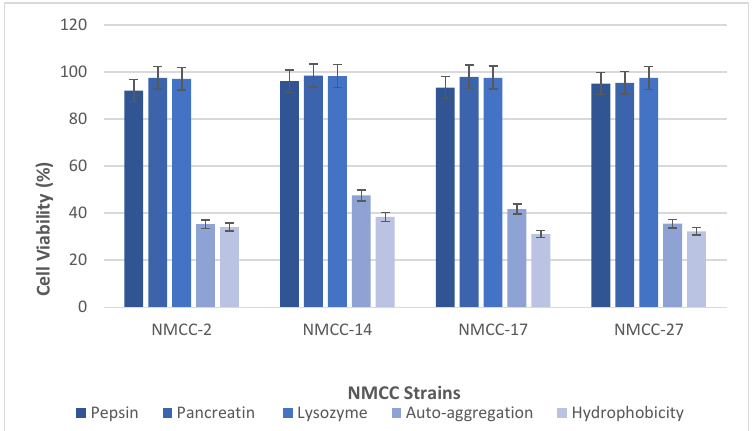
Figure 2. Evaluation of different physiological properties of LAB strains. In vitro values ( n = 3) are mean ± standard deviations. Different subscripts lowercase letters indicate significant differences ( p < 0.05).